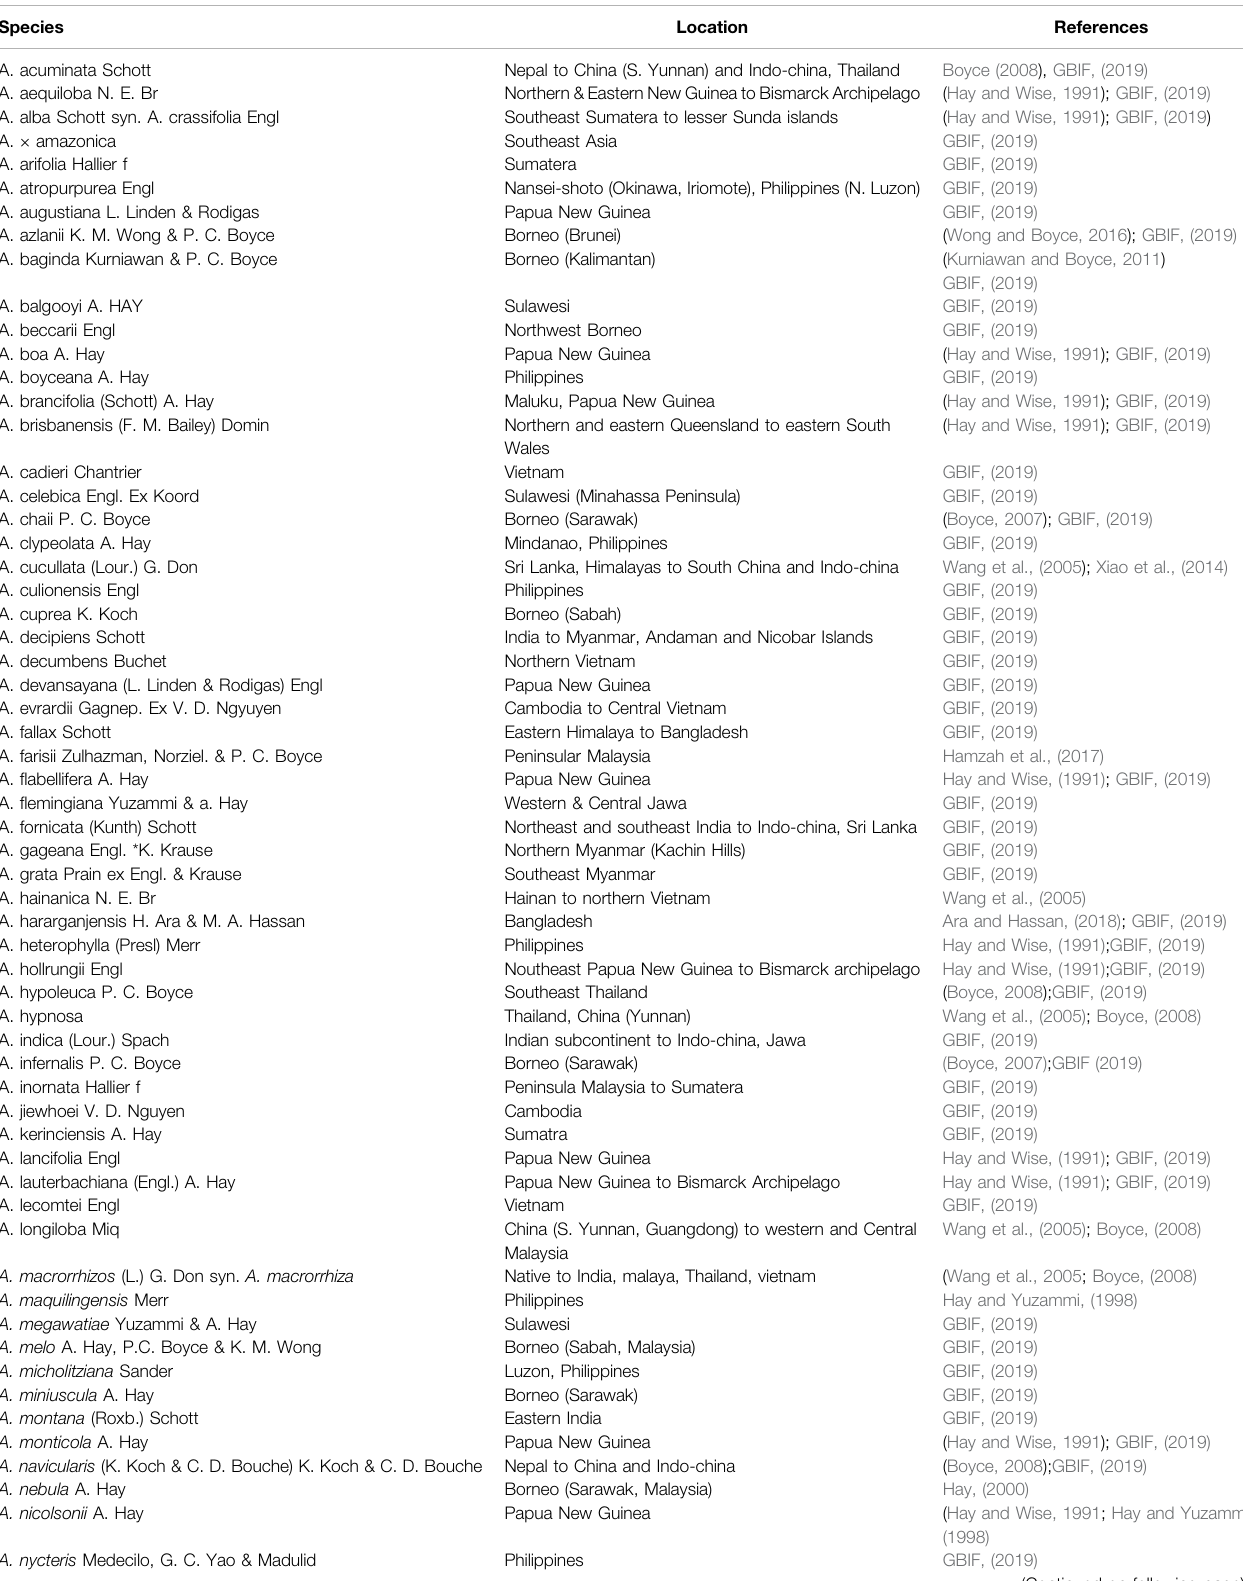
Table 1 | Distribution of Alocasia species